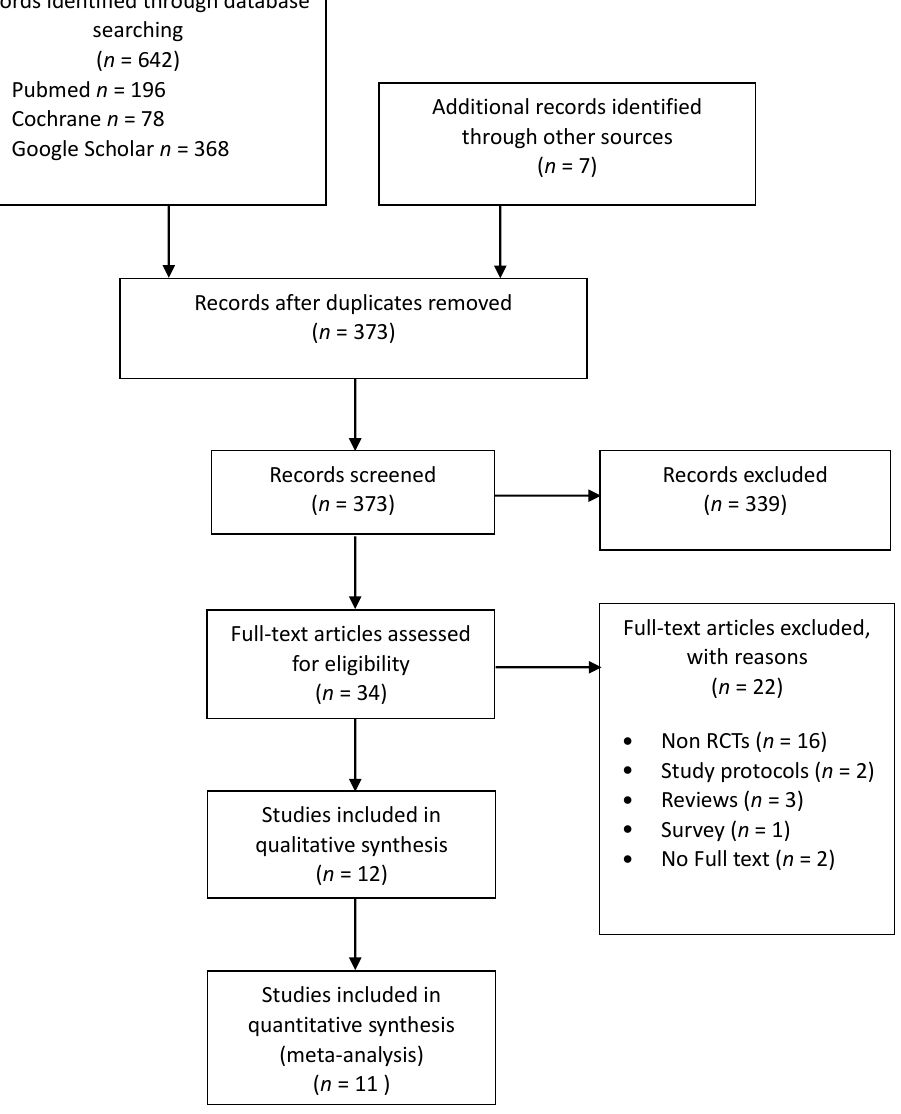
Figure 1. The PRISMA